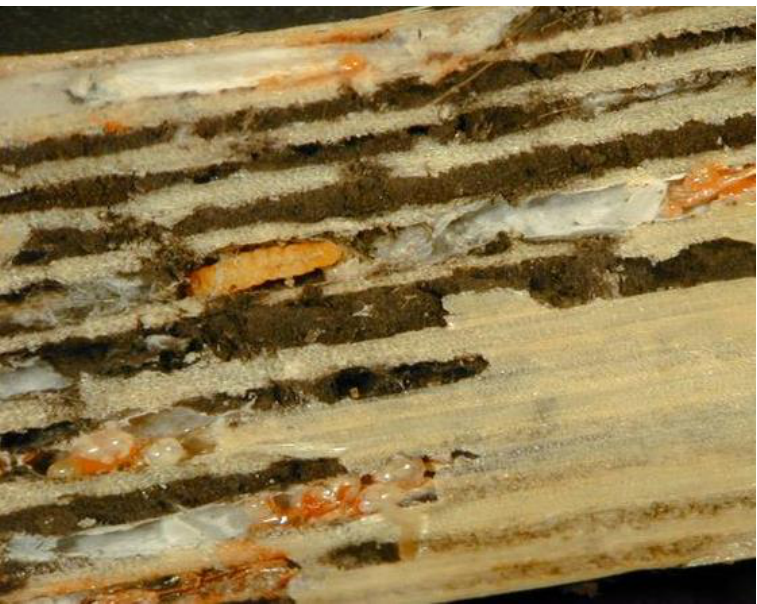
Figure 2. Fungal communities growing inside A. donax ’s leaf sheath galleries mined by L. donacis larvae.